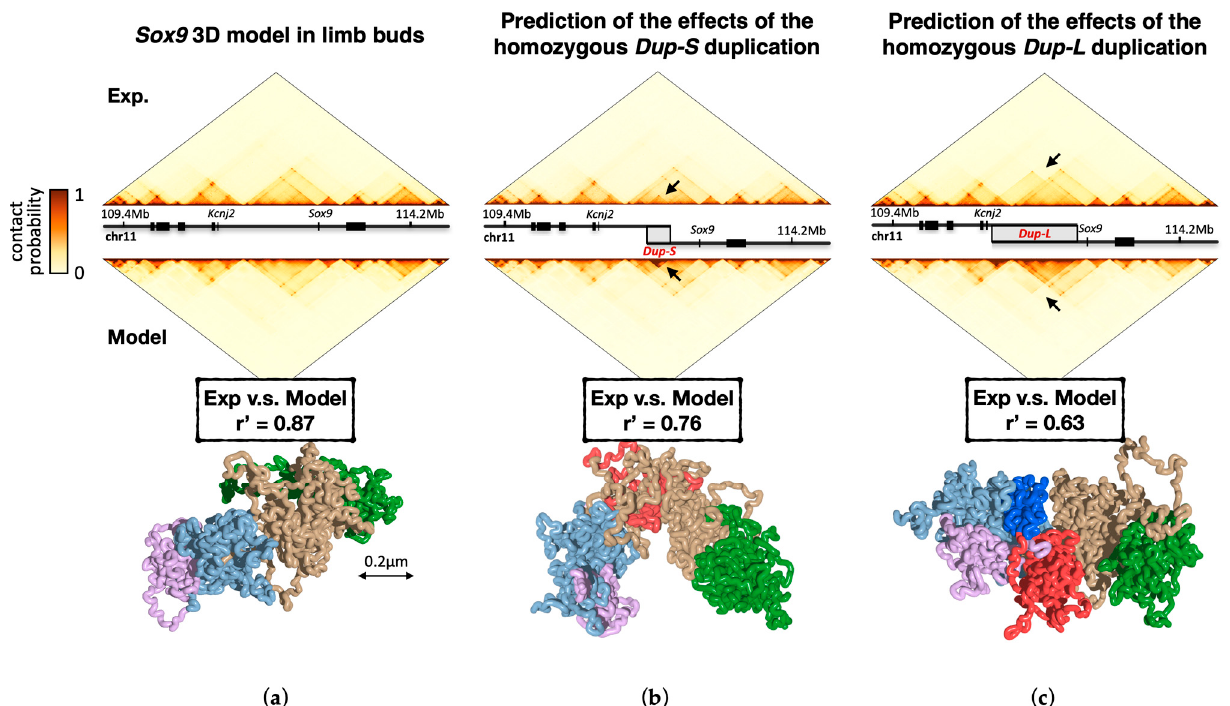
Figure 4. Prediction of the impact of genomic mutations. ( a ) Hi-C contact matrix [144] of the wild-type (WT) Sox9 genomic region ( top ) and its corresponding SBS model ( middle ) show high similarity (r’ = 0.87). Bottom : snapshot of a single-molecule conformation in the WT predicted by the model. ( b ) The model contact matrix ( middle ) in the Dup-S case, predicted by implementing the duplication on the WT model. It shows a high correlation (r’ = 0.76) with the corresponding matrix derived from an independent experiment ( top ) in cells bearing the Dup-S mutation. The black arrows highlight the effect of the duplication on the contact pattern. Bottom : snapshot of a model-predicted single-molecule conformation in Dup-S (note, in particular, how the duplicated region, highlighted in red, is well embedded into the original sequence, colored in brown). ( c ) The model contact matrix ( middle ) in the Dup-L case, predicted by implementing the duplication on the WT model. It shows a correlation with a matrix from an independent experiment ( top ) in cells bearing the Dup-L mutation as high as r’ = 0.63. The black arrows highlight the effect of the duplication on the contact pattern. Differently from the Dup-S case, a snapshot of the 3D structure in Dup-L ( bottom ) shows that a fraction of the duplicated region (neo-TAD, colored in red) results to be spatially isolated. This clarifies that different mutations result in different 3D structures and distinct enhancer-hijackings, explaining their phenotypes. Adapted from [95].